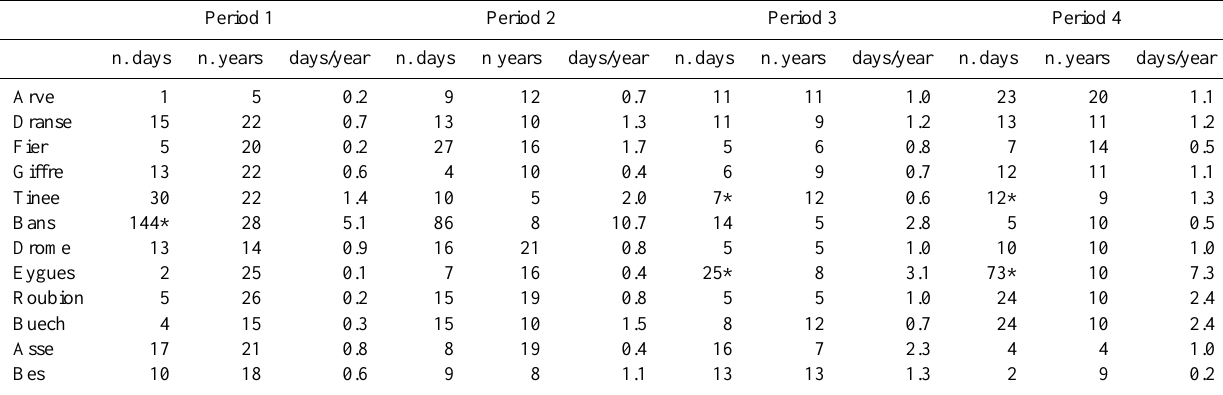
Table 3. The number of days, for each period and site, during which water flow exceeded Q 2 discharge (n. days). The number of years and days per year for each period are also shown. Period 1 = 1950/60–1970; Period 2 = 1970–1980; Period 3 = 1980–1990; Period 3 = 1990–2000.